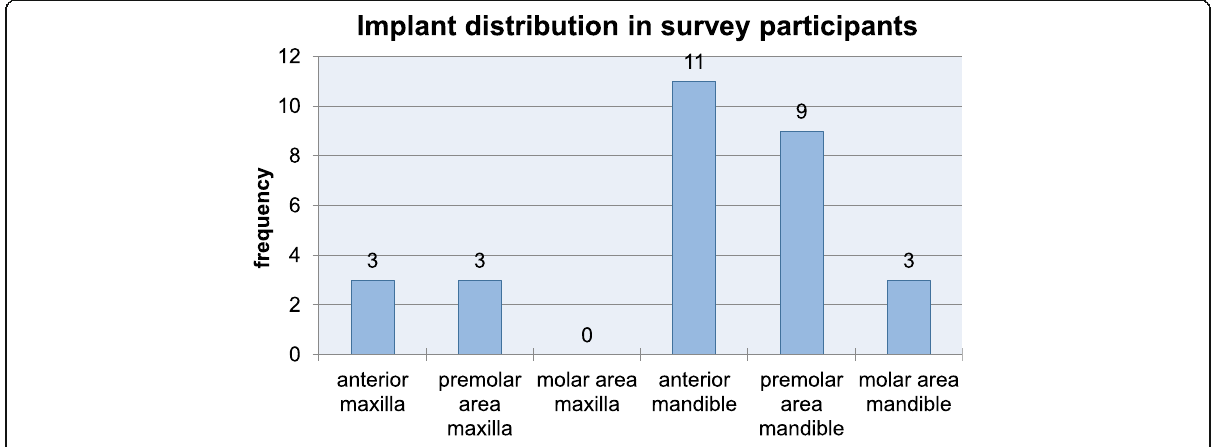
Fig. 13 Implant distribution in the participants of the survey at the end of the follow-up period